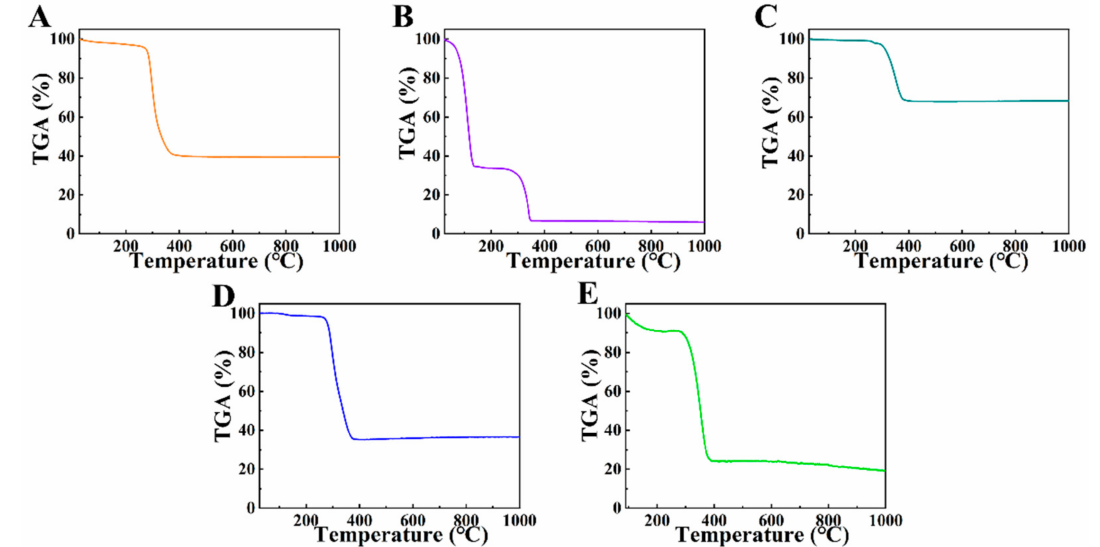
Figure 6. TGA data for ( A ) PMMA-HAP, ( B ) PMMA-Ag 2 O, ( C ) PMMA-ZnO, ( D ) PMMA-micron size silica and ( E ) PMMA-nanosilica